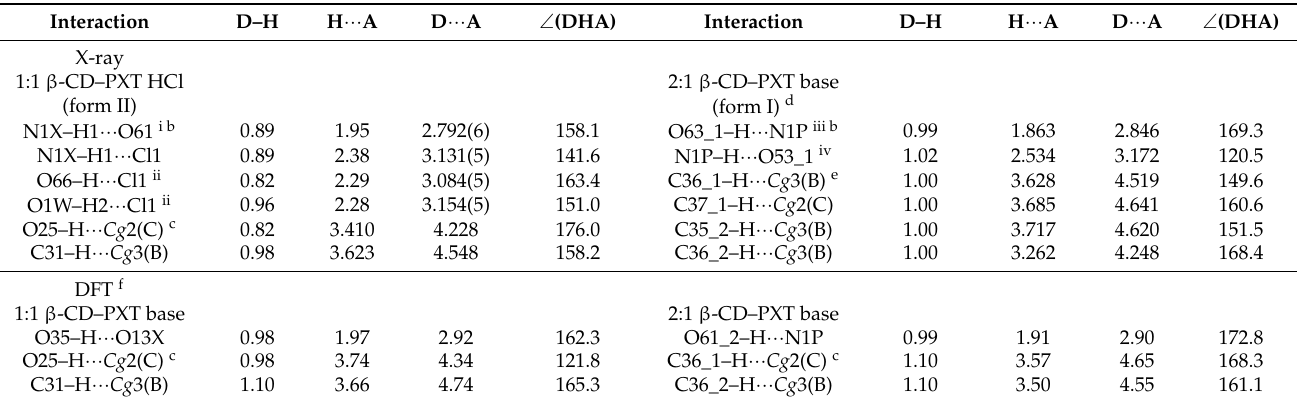
Table 2. Selected intermolecular interactions stabilizing the 1:1 and 2:1 β -CD–PXT inclusion com- plexes as derived from X-ray analysis and DFT calculation.